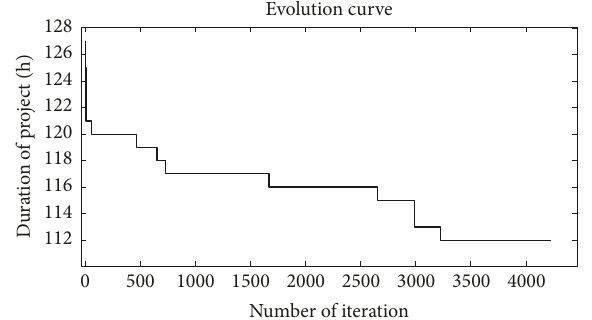
Figure 3: Evolution curve of the instance of